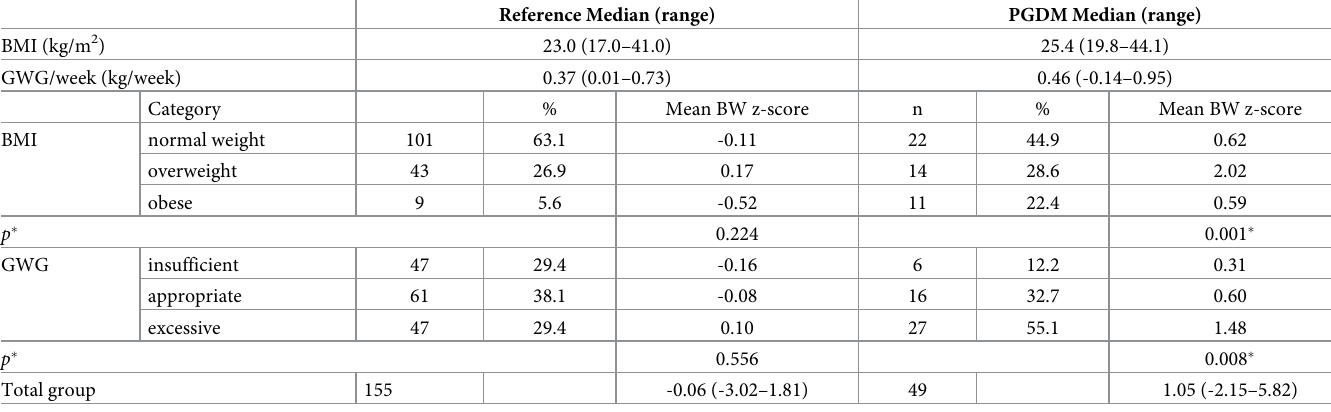
measured weight at inclusion (at median gestational age 9.4 weeks) and the self-reported pre- pregnancy weight in the study population was 2.0 kg. There was no difference in HbA between the various BMI or gestational weight gain categories, p = 0.72 and p = 0.35 respec- tively. The gestational age at birth was lower in the study population than in the reference pop- ulation, 37.8 weeks and 40.3, respectively [14].